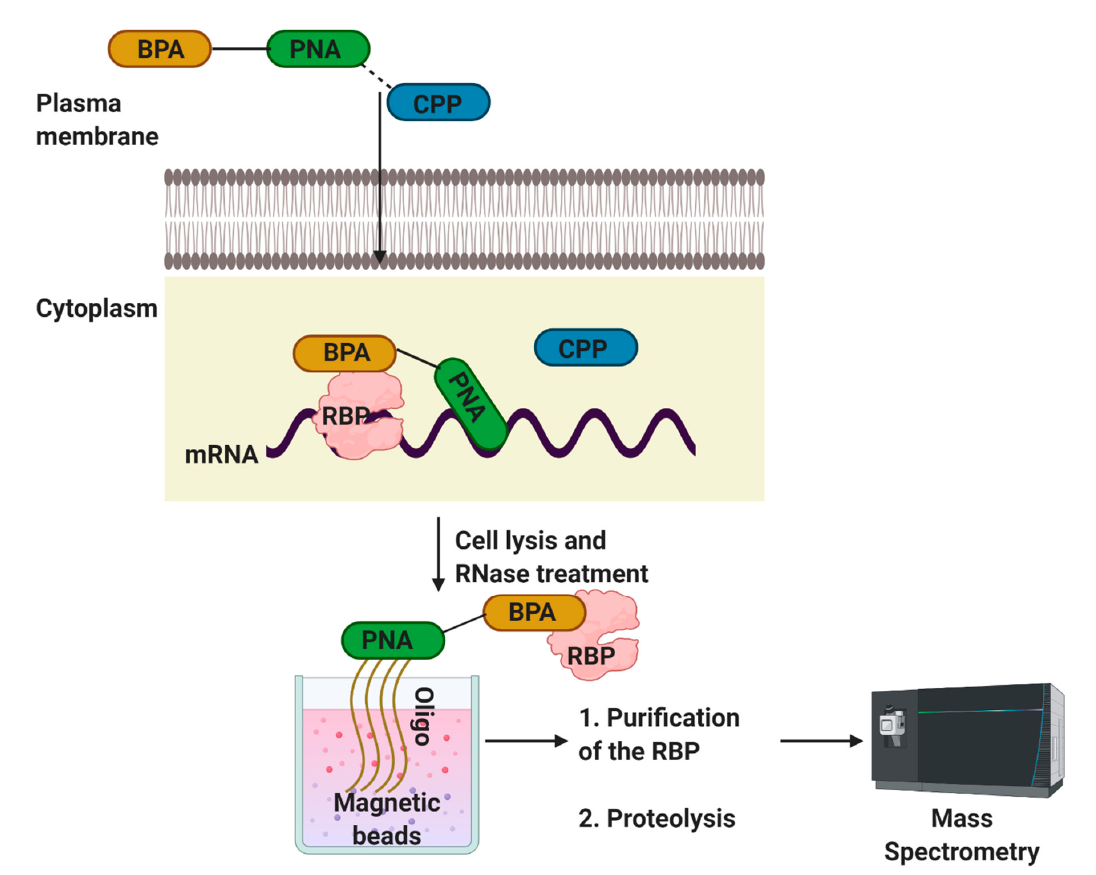
Figure 6. Schematic of the PAIR technology. A method using peptide-nucleic-acid-assisted identification of RBPs [63,66]. Peptide nucleic acid (PNA), cell membrane-penetrating peptide (CPP), p -benzoylphenylalanine (BPA).